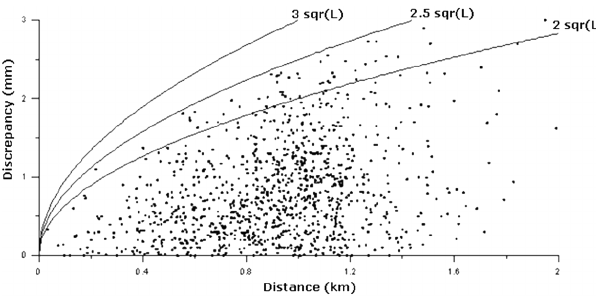
Figure 2. Levelling campaign 2005: discrepancies vs. distance for the forward and backward runs of the section height